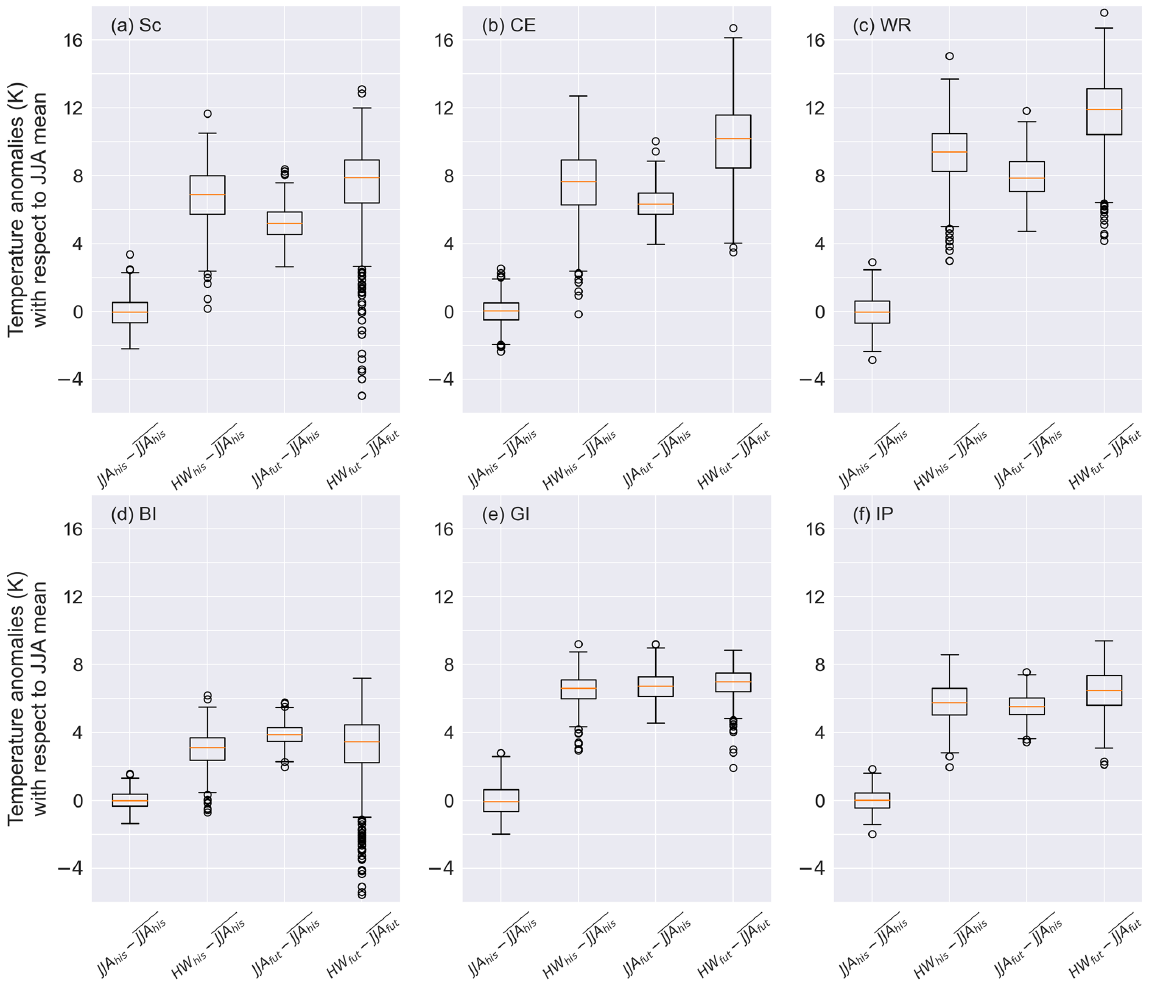
Figure 2. Temperature anomalies at 12:00UTC (in Kelvin) with respect to the JJA mean temperature per time slice (JJA his , JJA fut ) in the regions (a) Sc, (b) CE, (c) WR, (d) BI, (e) GI and (f) IP. JJA mean temperatures are calculated over each year of the time slice (historic: 1991– 2000; future: 2091–2100) and each ensemble member. The heatwave temperatures are determined as spatial average temperature per region for each heatwave day. Note that no differentiation between grid points over land/ocean are made here. For the first three boxes from the left, temperature anomalies are calculated by subtracting the JJA mean temperature JJA his of the historic time slice. The second (fourth) box shows the historic (future) heatwave (HW) temperature HW his (HW fut ) anomalies with respect to the JJA mean temperature JJA his (JJA fut ) of the (historic) future time slice. The box spans the 25th and 75th percentile of the data, the horizontal (orange) line inside the box gives the median, and the whiskers are given by 1.5 times the interquartile range; flier points are those that are outside the range of the